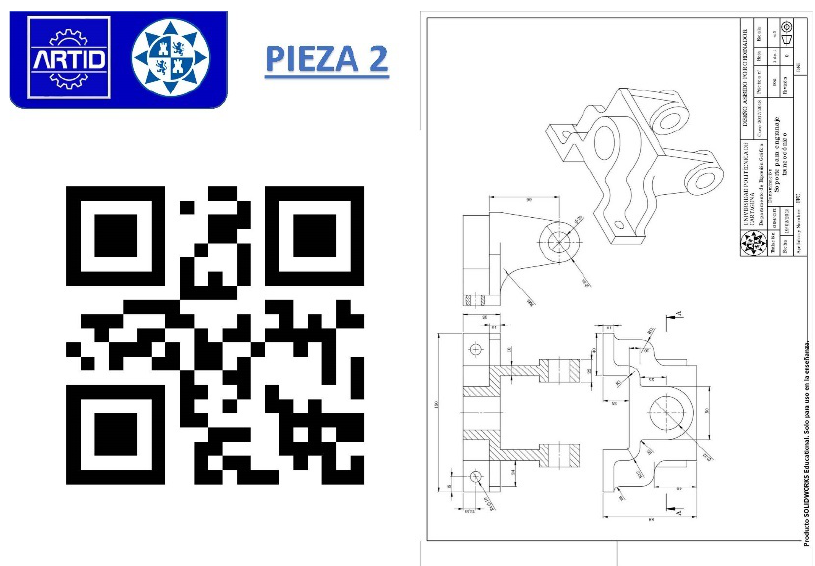
Figure 7. One of the plans with a QR code used in the test.